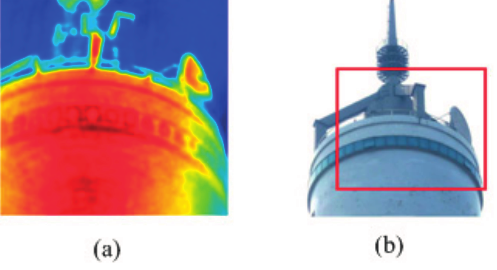
Figure 5. ( a ) Real passive millimeter SAIR image of a tower. ( b ) Visible light image of the tower.